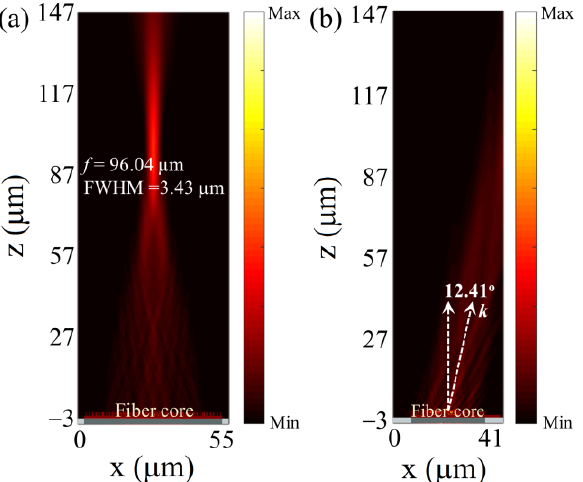
Figure 8. Performances of a monolithic metasurface ( a ) metalens and ( b ) beam deflector on multimode fiber tips, respectively. The diameter of the fiber core is as large as that of the correspondingly supported metasurface, i.e., ( a ) 50 μm and ( b ) 28.6 μm.